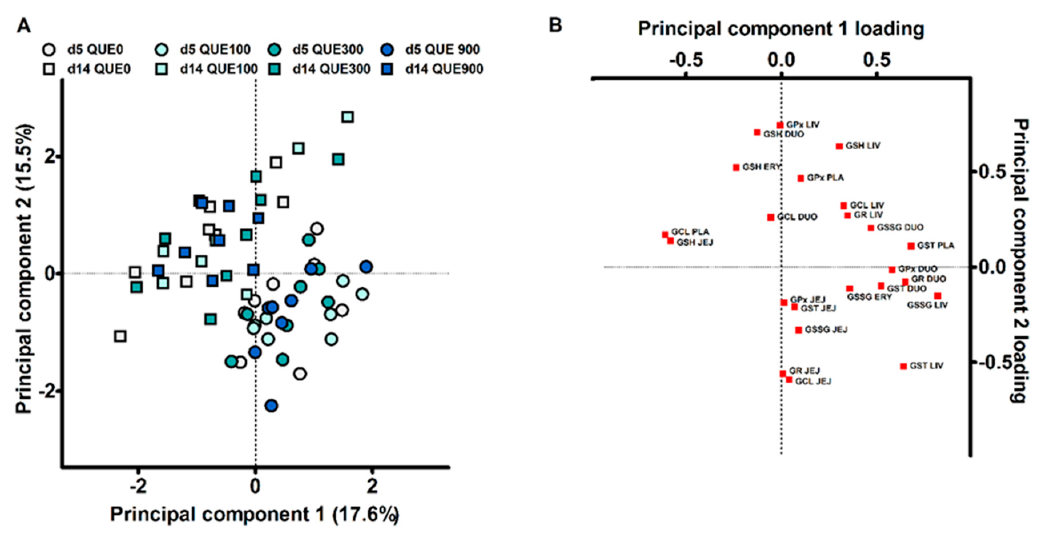
Figure 5. Principal component analysis of glutathione redox system in four different tissues of piglets at d5 and d14 post-weaning (DAY), fed a diet containing either 0, 100, 300, or 900 mg quercetin/kg diet (QUE) during the first 14d post-weaning: ( A ) Scores plot representing the 64 individual piglets in the multivariate space of the first two principal components. Animals can be visually clustered according to day post-weaning (d5 or d14). ( B ) Loading plot of the two major principal components. GPx = glutathione peroxidase, GR = glutathione reductase, GST = glutathione transferase; GCL = glutamate-cysteine ligase; GSH = glutathione; GSSG = glutathione dissulphide; PLA = plasma; ERY = erythrocyte; DUO = duodenum; JEJ = distal jejunum; LIV = liver.